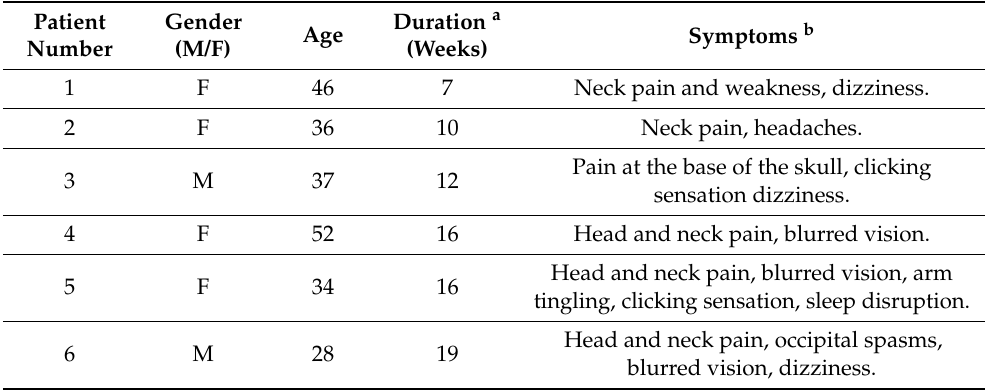
Table 1. Patient